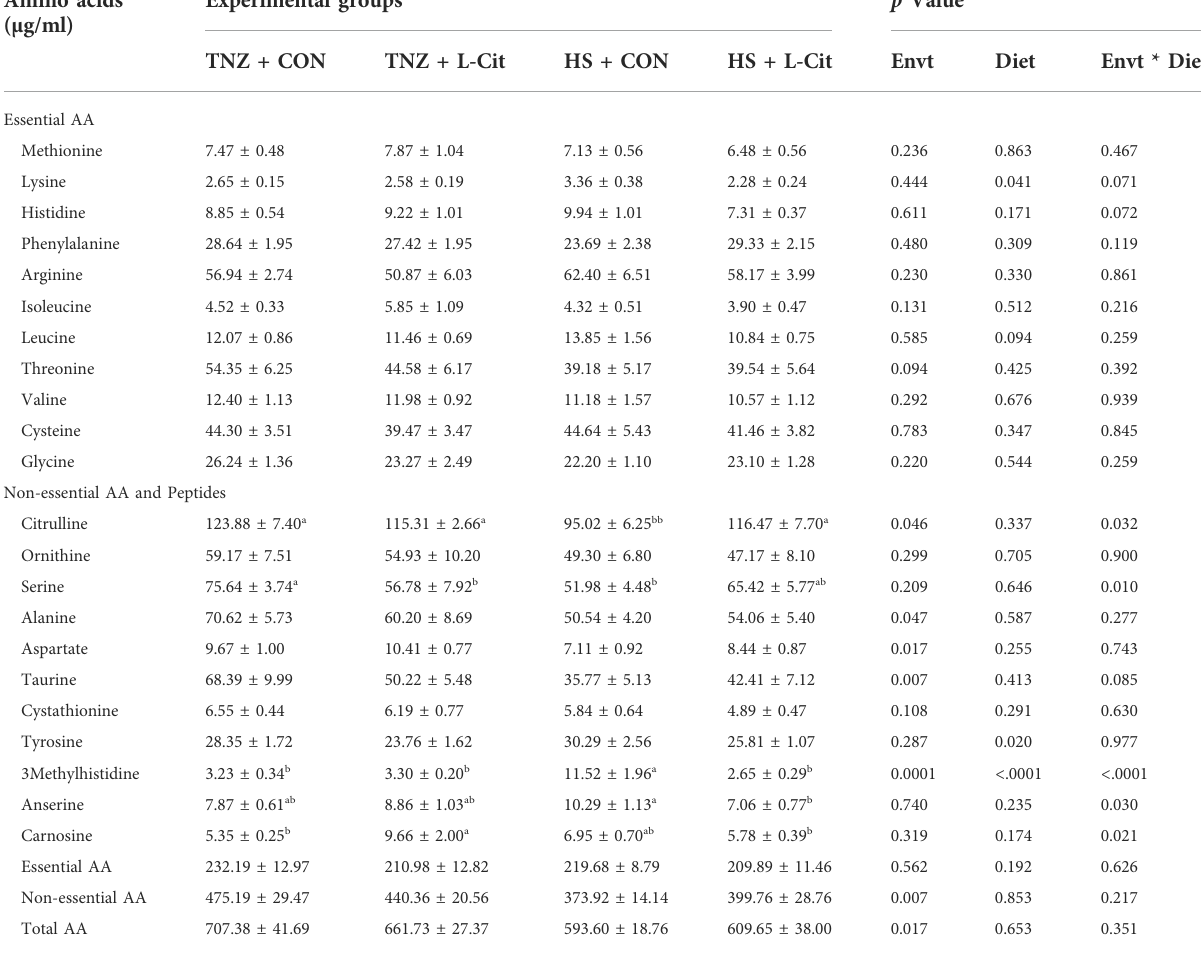
TABLE 6 Effects of heat stress and L-citrulline supplementation on the serum amino acid composition of broilers. Amino acids